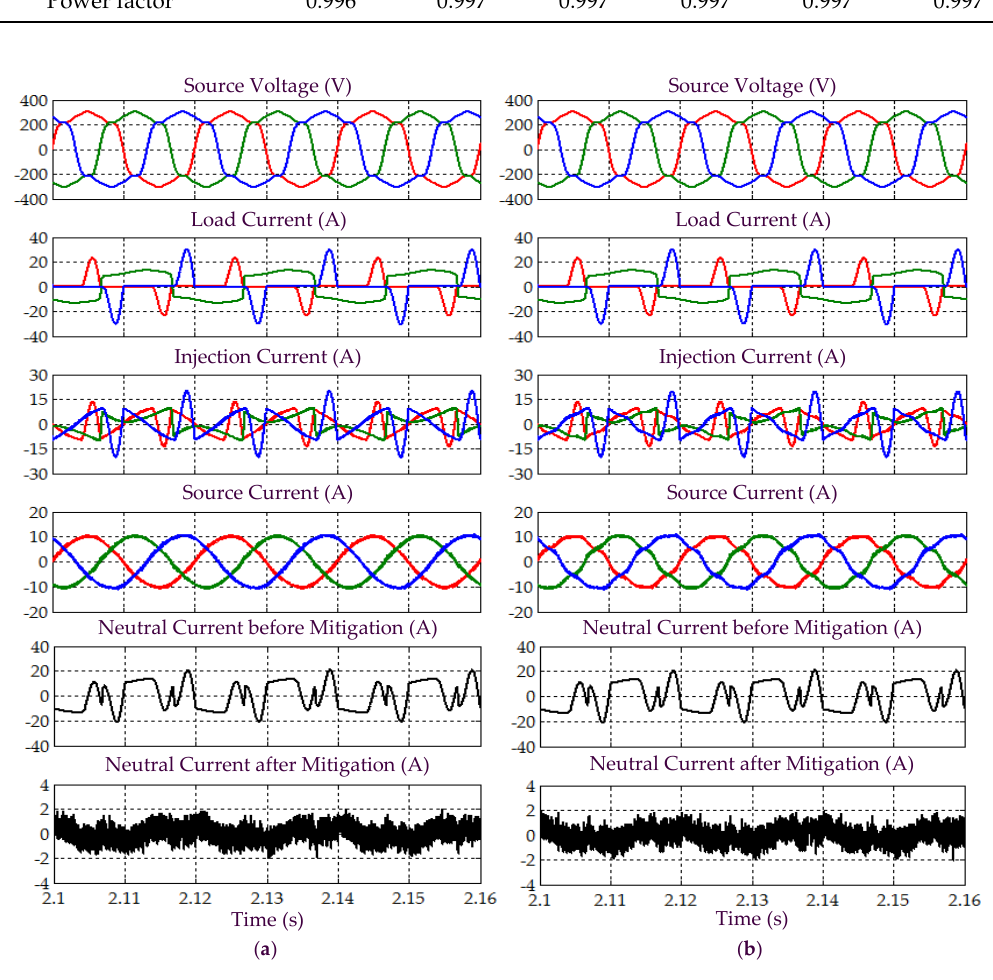
Figure 11. Simulation results obtained under Scenario B for Load 1, which include three-phase source voltage v Sabc , load current i Labc , injection current i injabc , source current i Sabc , and neutral current before and after mitigation, demonstrated by SAPF while applying the ( a ) proposed STF- dq 0 and ( b ) standard dq 0